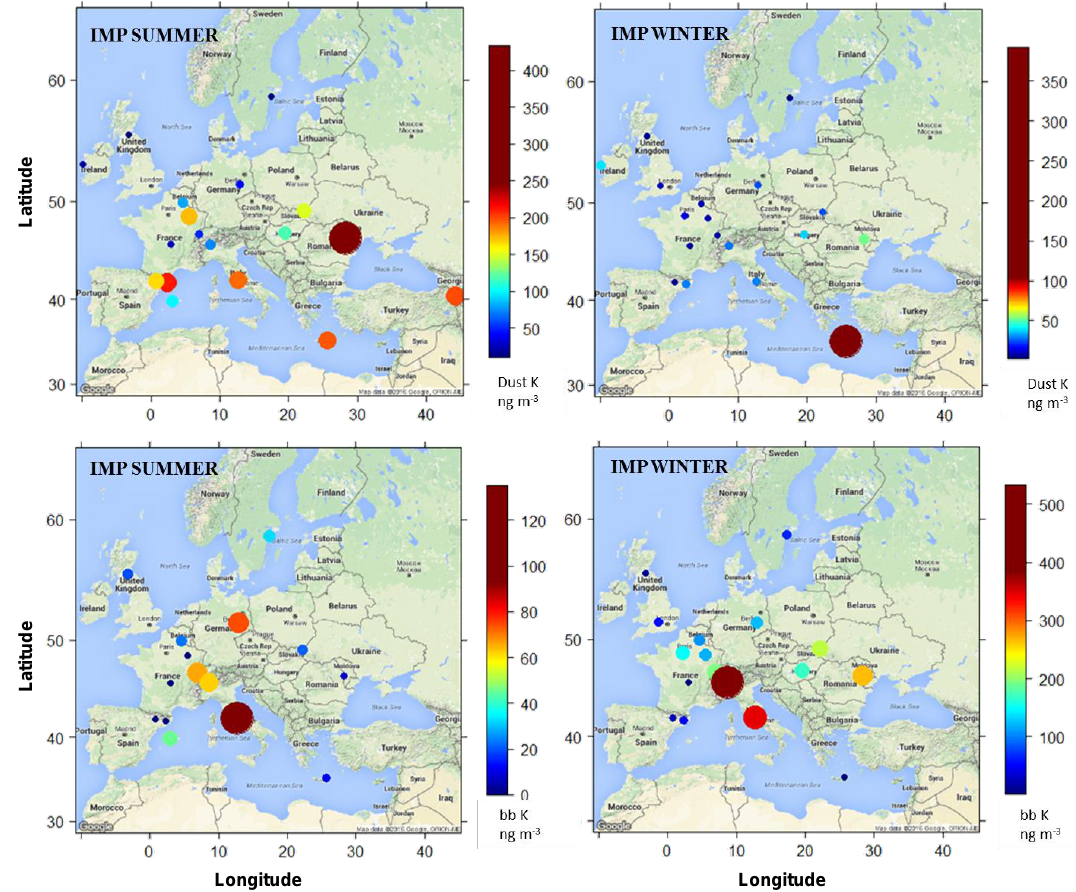
Figure 6. Spatial distribution of the estimated average concentrations (in ngm − 3 ) of the mineral (dustK) and the biomass burning (bbK) potassium at each site in the summer 2012 and winter 2013 IMPs. The diameter of the circles is proportional to the